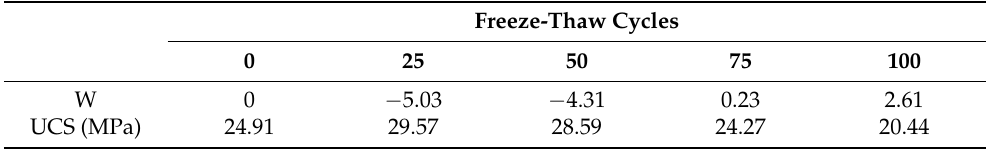
Table 4. Changes of W and UCS with freeze-thaw cycles.